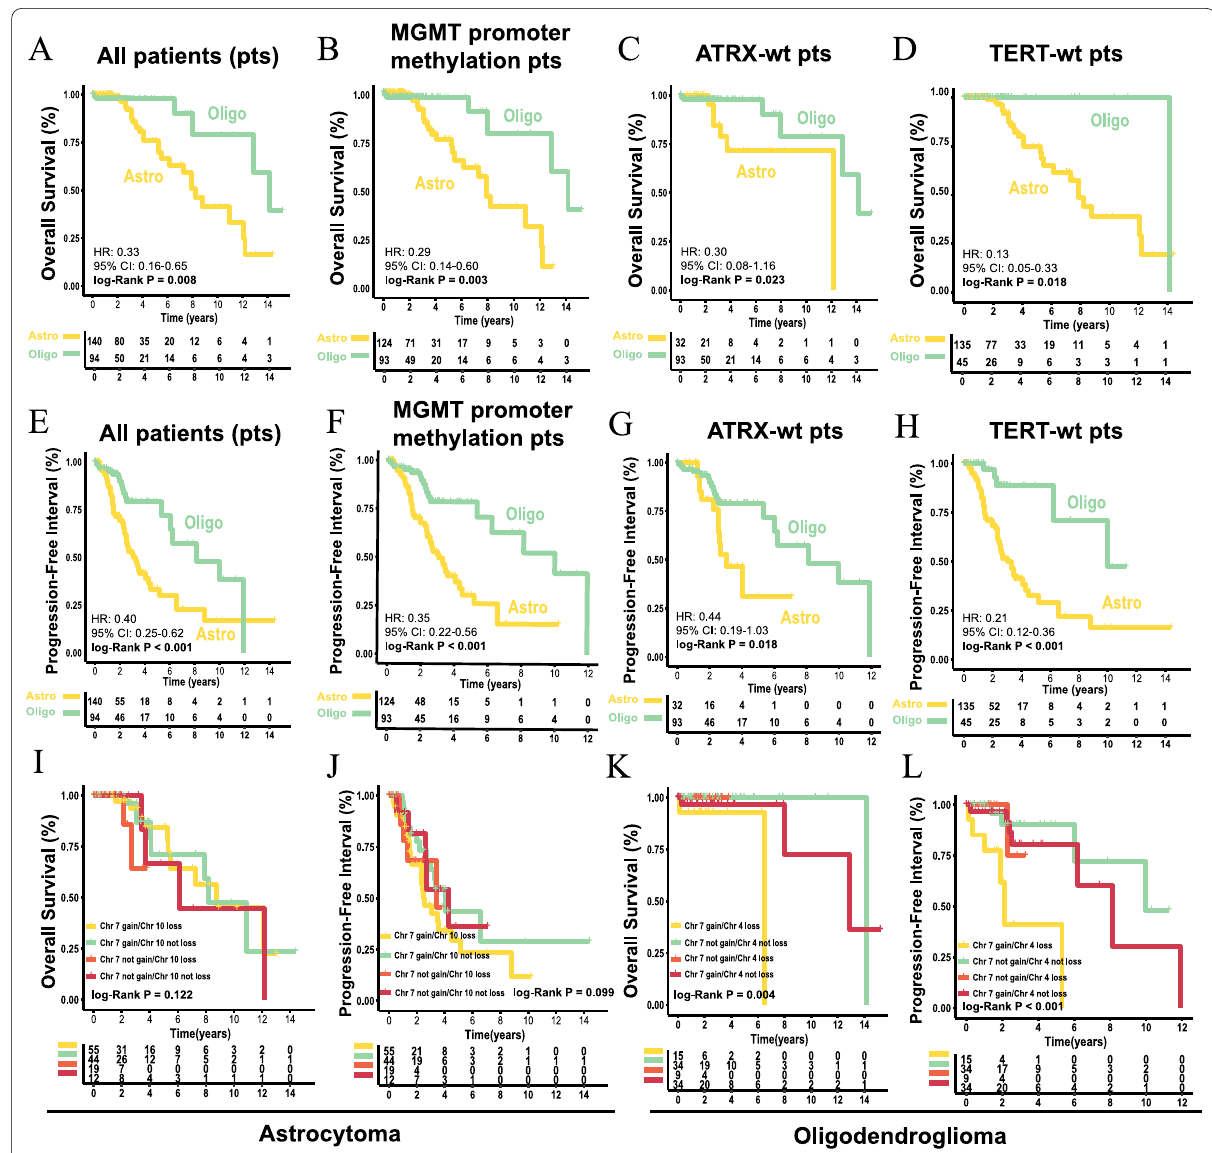
Fig. 3 Prognostic analyses based on tumor subtyping. A–D Overall survival (OS) of all patients ( A ), MGMT promoter methylation patients ( B ), ATRX wild type patients ( C ) and TERT wild type patients ( D ) between astrocytoma and oligodendroglioma. E–H Progression-free interval (PFI) for all patients ( E ), MGMT promoter methylation patients ( F ), ATRX wild type patients ( G ), and TERT wild type patients ( H ) between astrocytoma and oligodendroglioma. I‑J OS ( I ) and PFI ( J ) for astrocytoma patients regarding chr 7/chr 10 status. K–L OS ( K ) and PFI ( L ) for oligodendroglioma patients regarding chr 7/chr 4 status. OS overall survival, PFI progression-free interval, Astro astrocytoma, Oligo oligodendroglioma, pts patients. P-value was calculated by log-rank